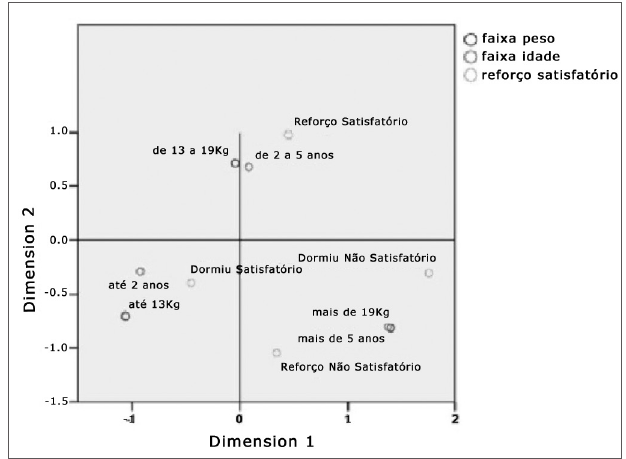
Figura 1. Mapa perceptual das variáveis relativas a faixas etárias, faixas de peso e se houve ou não reforço com efeito satisfatório ou